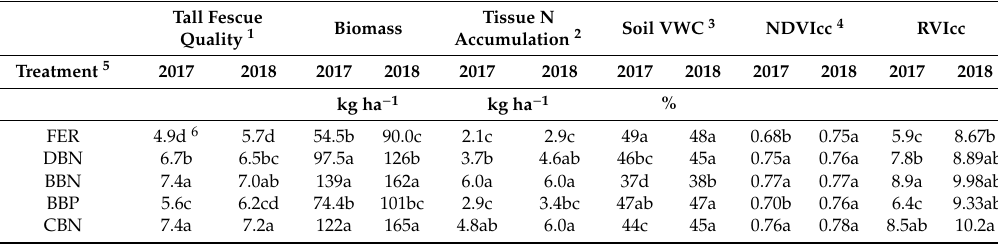
Table 8. Fertility amendments e ff ects on turfgrass quality, biomass, leaf tissue N accumulation, soil volumetric water content (VWC), normalized vegetation index (NDVI) and simple ratio vegetation index (RVI). Means reported are the average among the sampling dates for each year. Sampling was conducted between April and October for 2017 and between April and August of 2018.